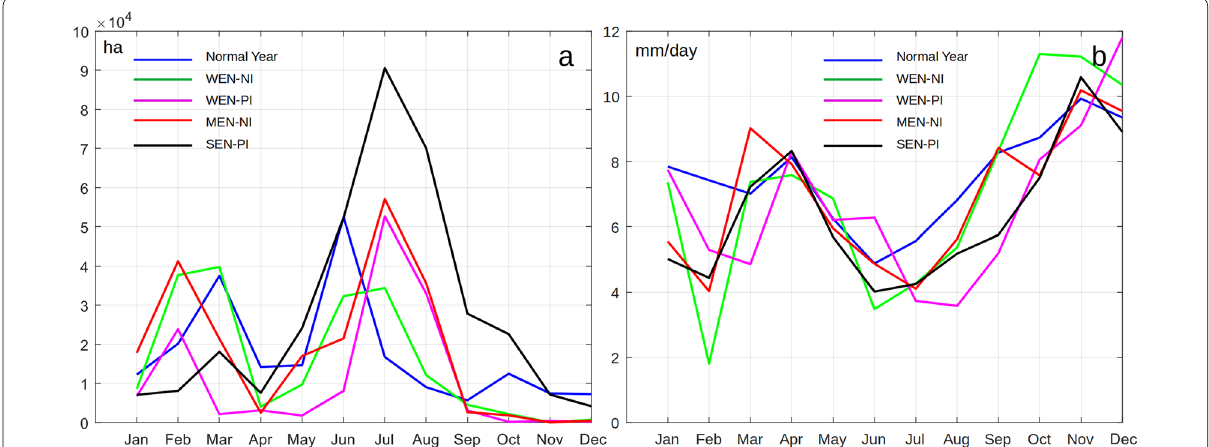
Fig. 9 Temporal of joint pattern for each category on Riau with ( a ) represent burned area and ( b ) represent precipitation. The January–April graph is obtained from the 1st dry season analysis, while the May until December graph is obtained from the 2nd dry season, which is done